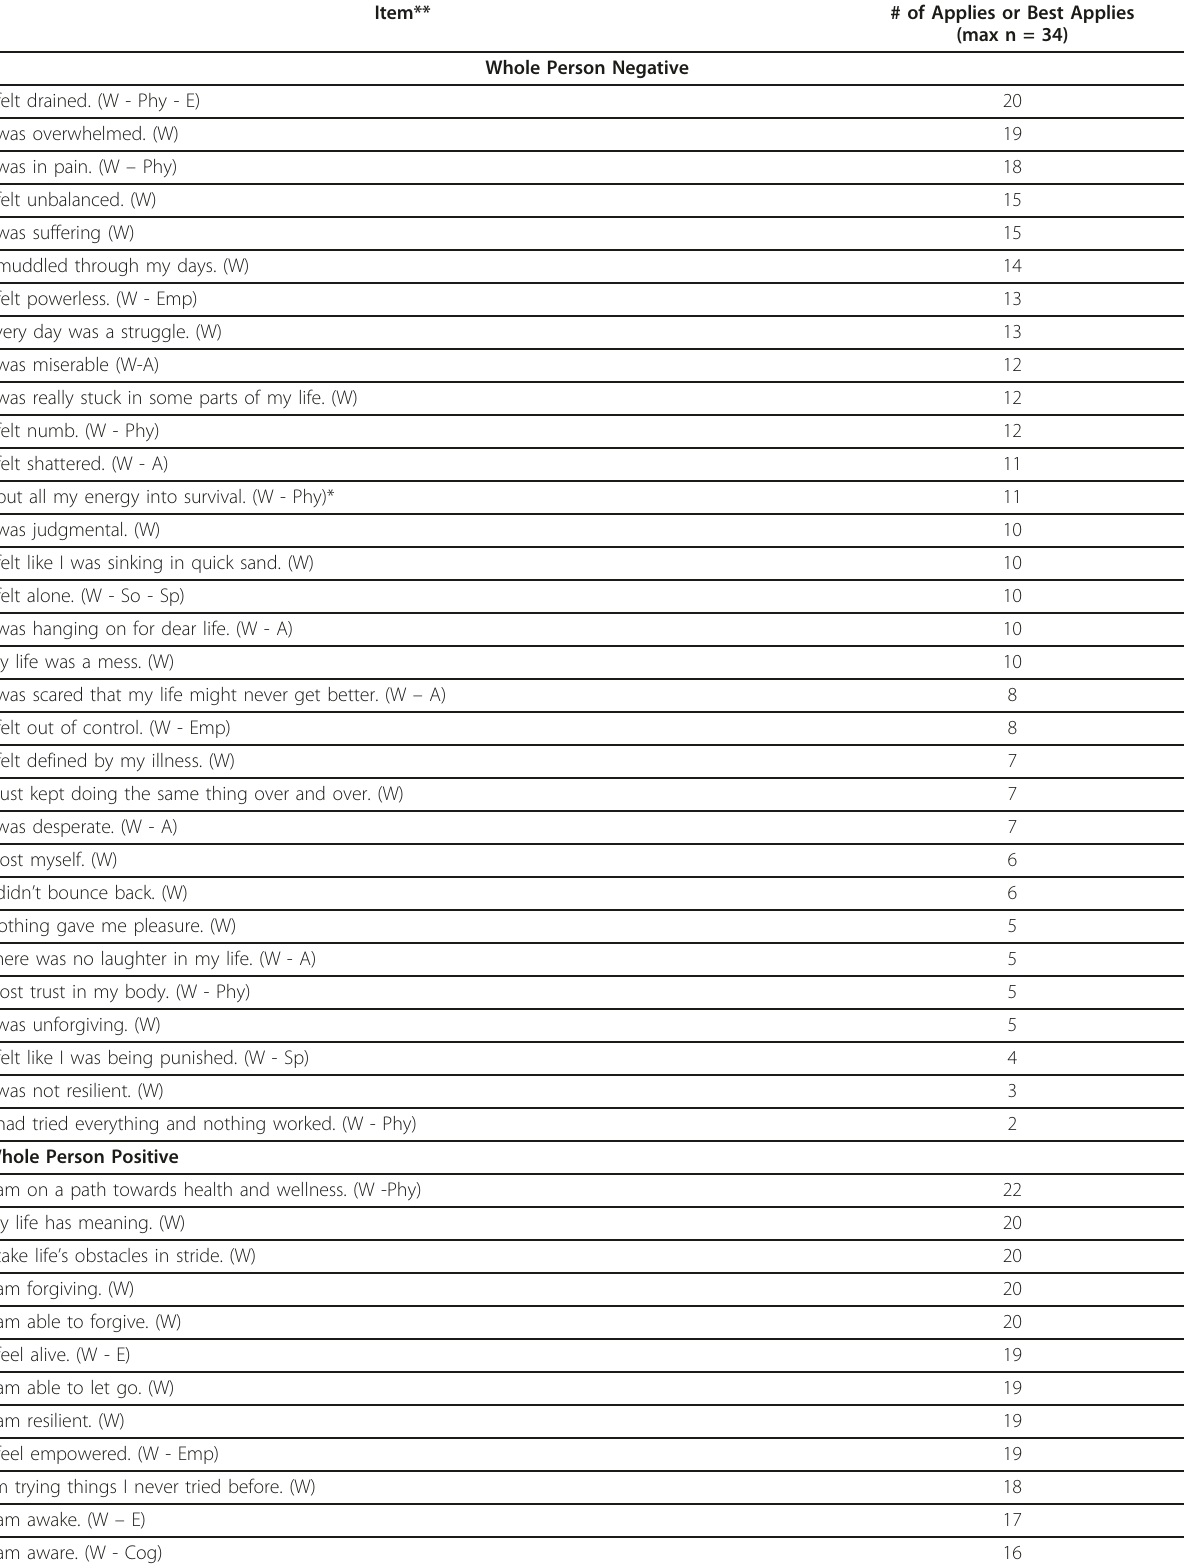
Table 4 Complete List of Positive and Negative Items by Level of Endorsement* Sorted by Psychometric Domains Item** # of Applies or Best Applies (max n = 34) Whole Person